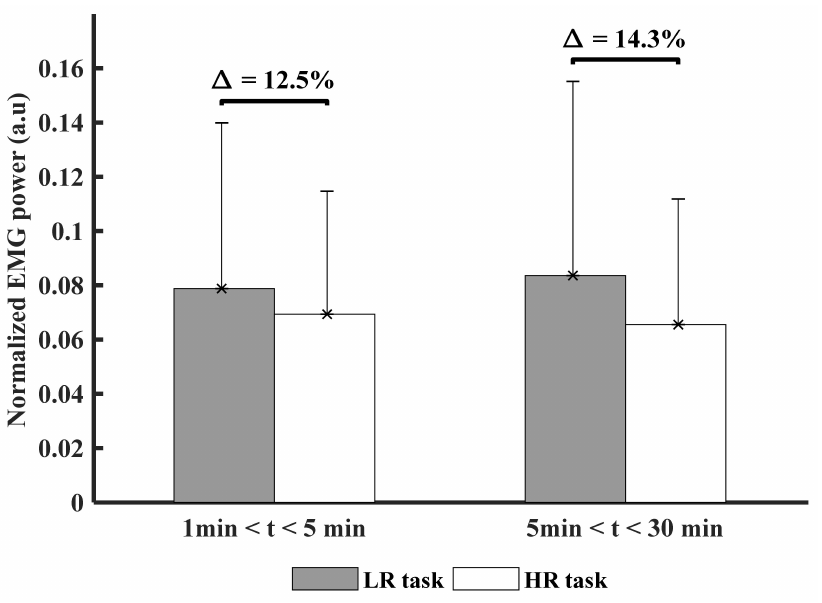
Figure 4. Comparison of the average of the normalized EMG PSD for all participants between both experimental task conditions (LR: Low Risk and HR: High risk). ∆ indicates the percentage of difference between both experimental task conditions.